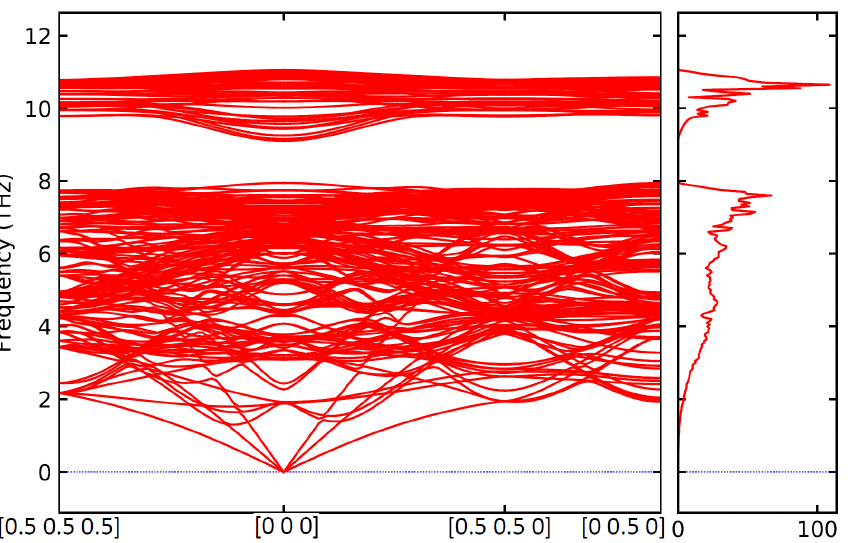
Figure 3. Computed phonon frequencies along selected directions in the reciprocal space and the density of phonon states in the case of Cu-containing crystals of Fe 3 Al (without APBs). Next, we evaluated Helmholtz free energy F , the entropy S , harmonic phonon energy E , and constant-volume heat capacity C v (see them visualized in Figure 4).